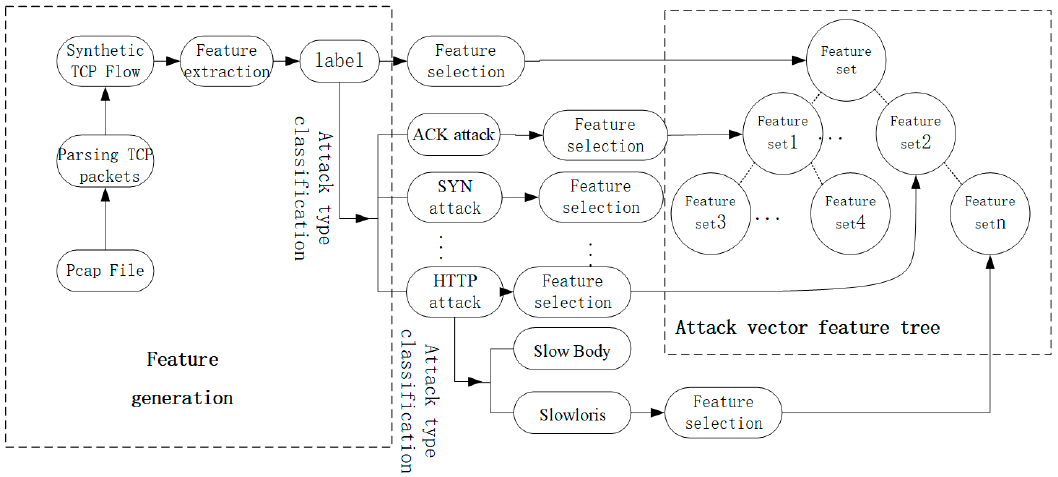
Figure 1. Attack vector feature tree generation.